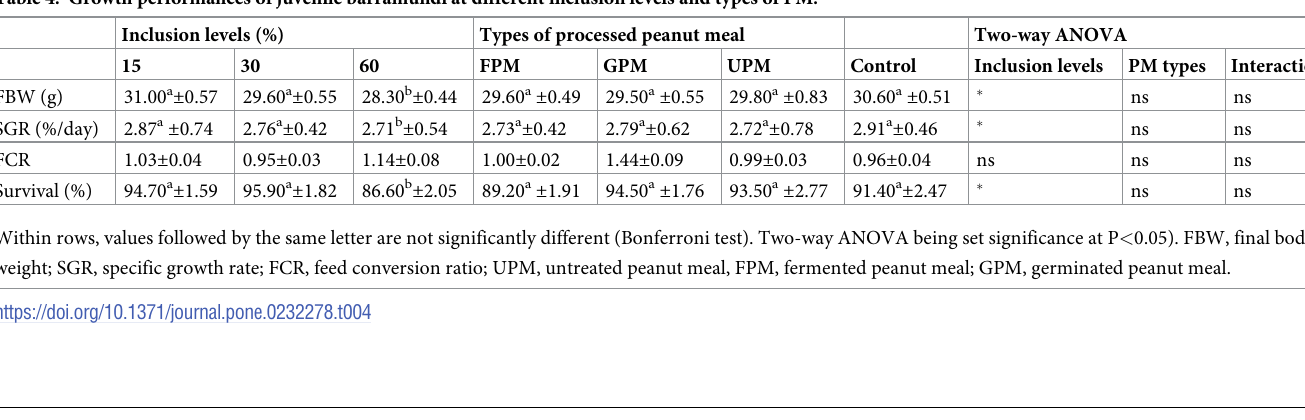
Data are expressed in mean and standard error of the mean of 3 samples. Within columns, values followed by the same letter are not significantly different (P > 0.05).